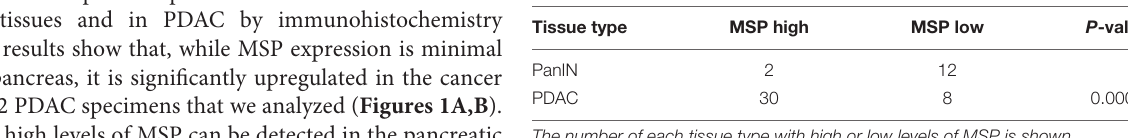
TABLE 1 | Macrophage-stimulating protein (MSP) levels in tissue micro array (TMA) of Pancreatic intraepithelial neoplasias (PanIN), and Pancreatic ductal adenocarcinoma